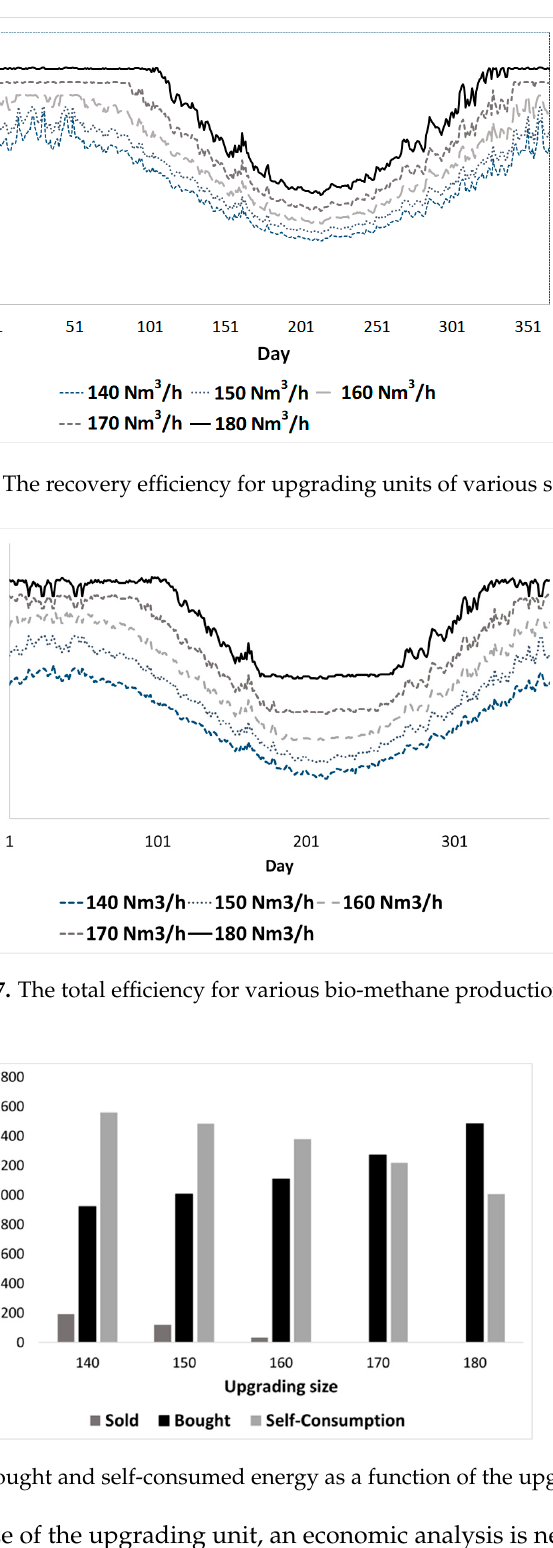
Figure 15 . The micro-gas turbine (mGT) power output ( a ) and electric efficiency ( b ) for various sizes of upgrading unit.